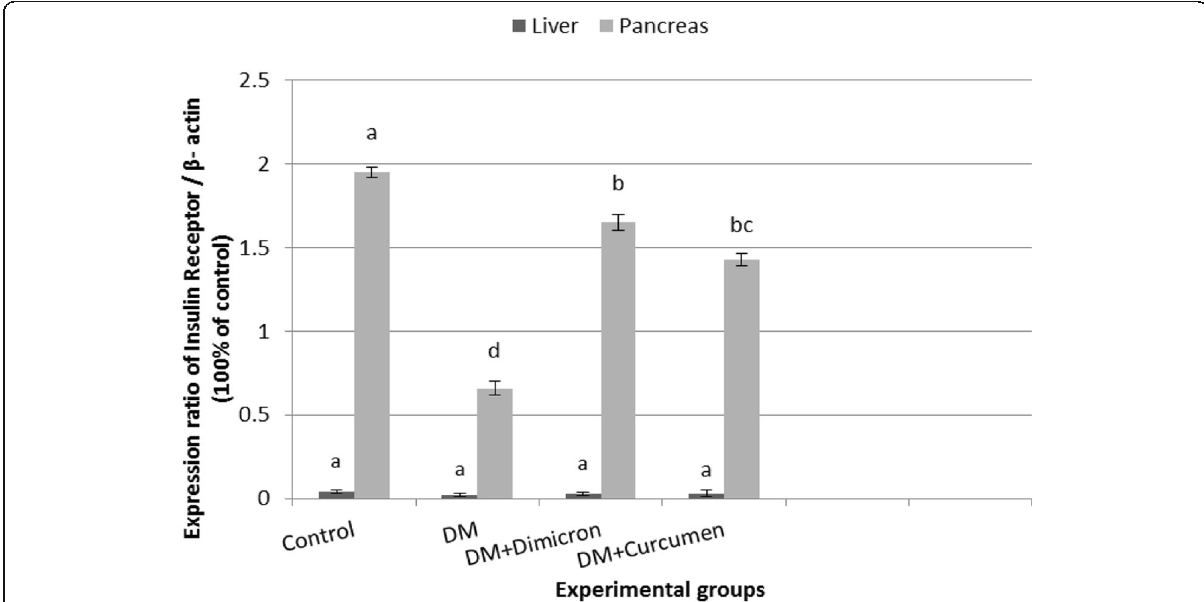
Fig. 6 The alterations of insulin receptor-mRNA in liver and pancreas tissues collected from female DM rats treated with curcumin nanoparticles. a,b,c Mean values ± standard deviation within tissue with unlike superscript letters were significantly different ( P <